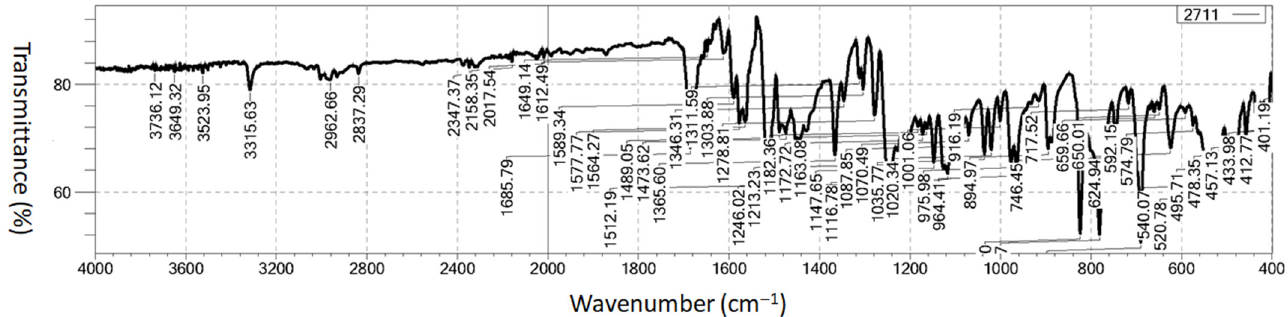
Figure 7. The experimental infrared spectrum of 2